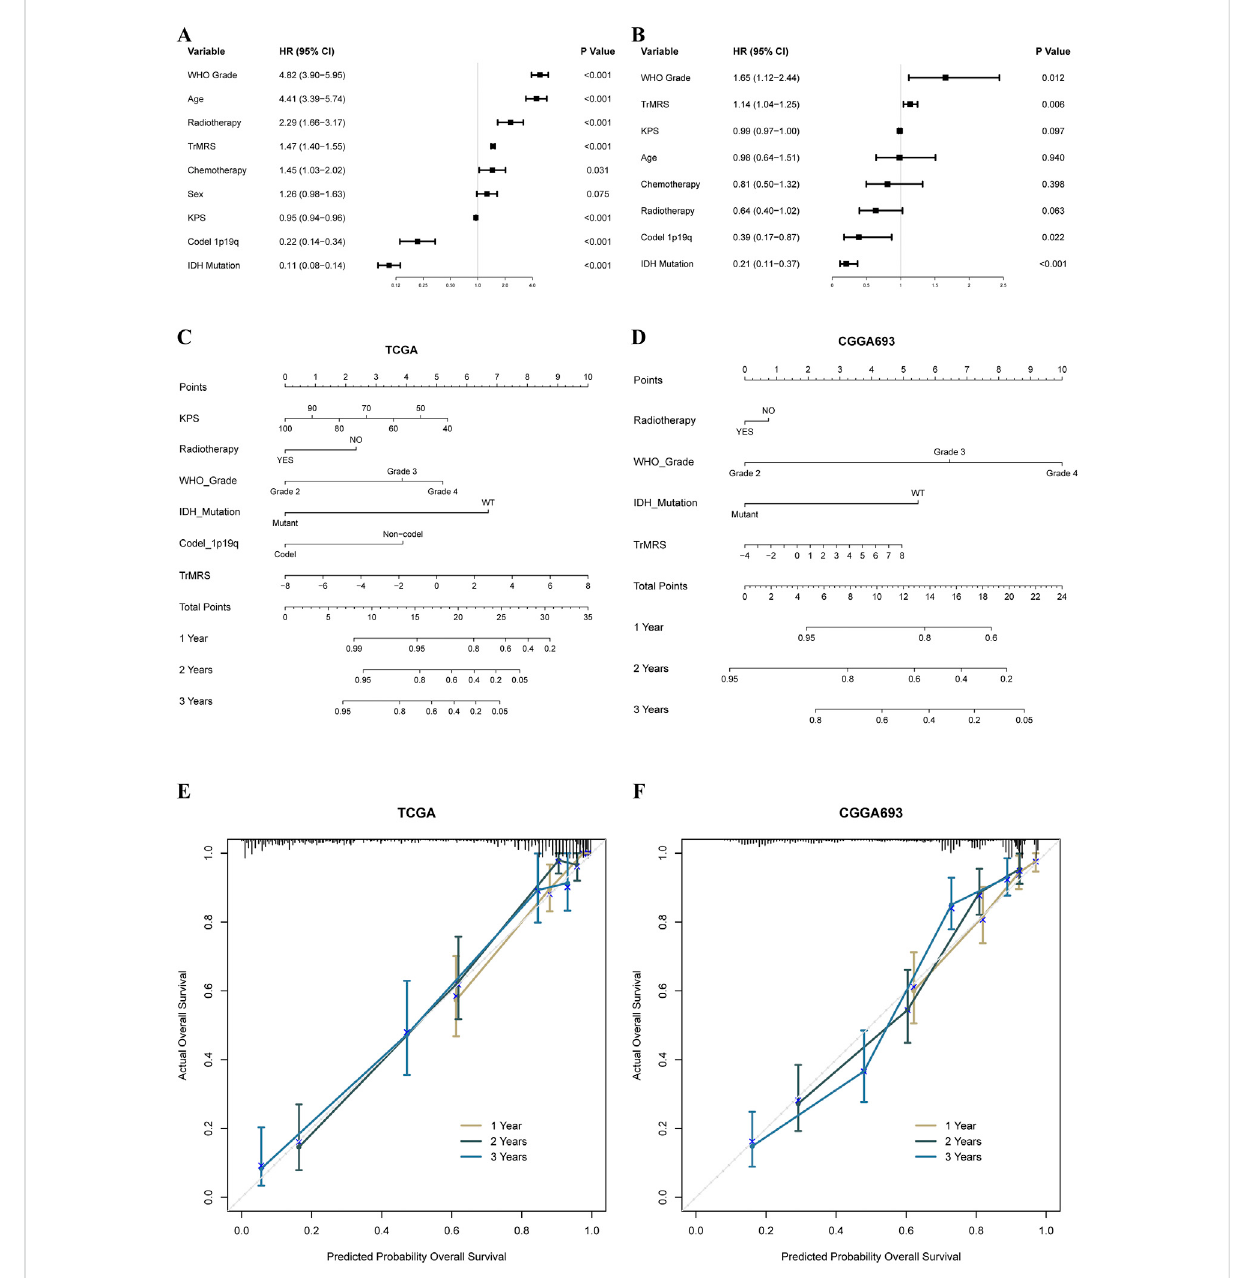
FIGURE 7 Prognostic value of TrMRS and construction of TrMRS-based nomograms. (A) Univariate and (B) Multivariate Cox regression analyses of potentialprognosticfactorsinoverallsurvivalofgliomas.Nomogramof1-,2-,and3-yearssurvivalofgliomapatientsbasedon (C) TCGAcohort( N = 655), (D) CGGA cohort ( N = 415). Calibration plots of the nomogram based on (E) TCGA cohort and (F) CGGA